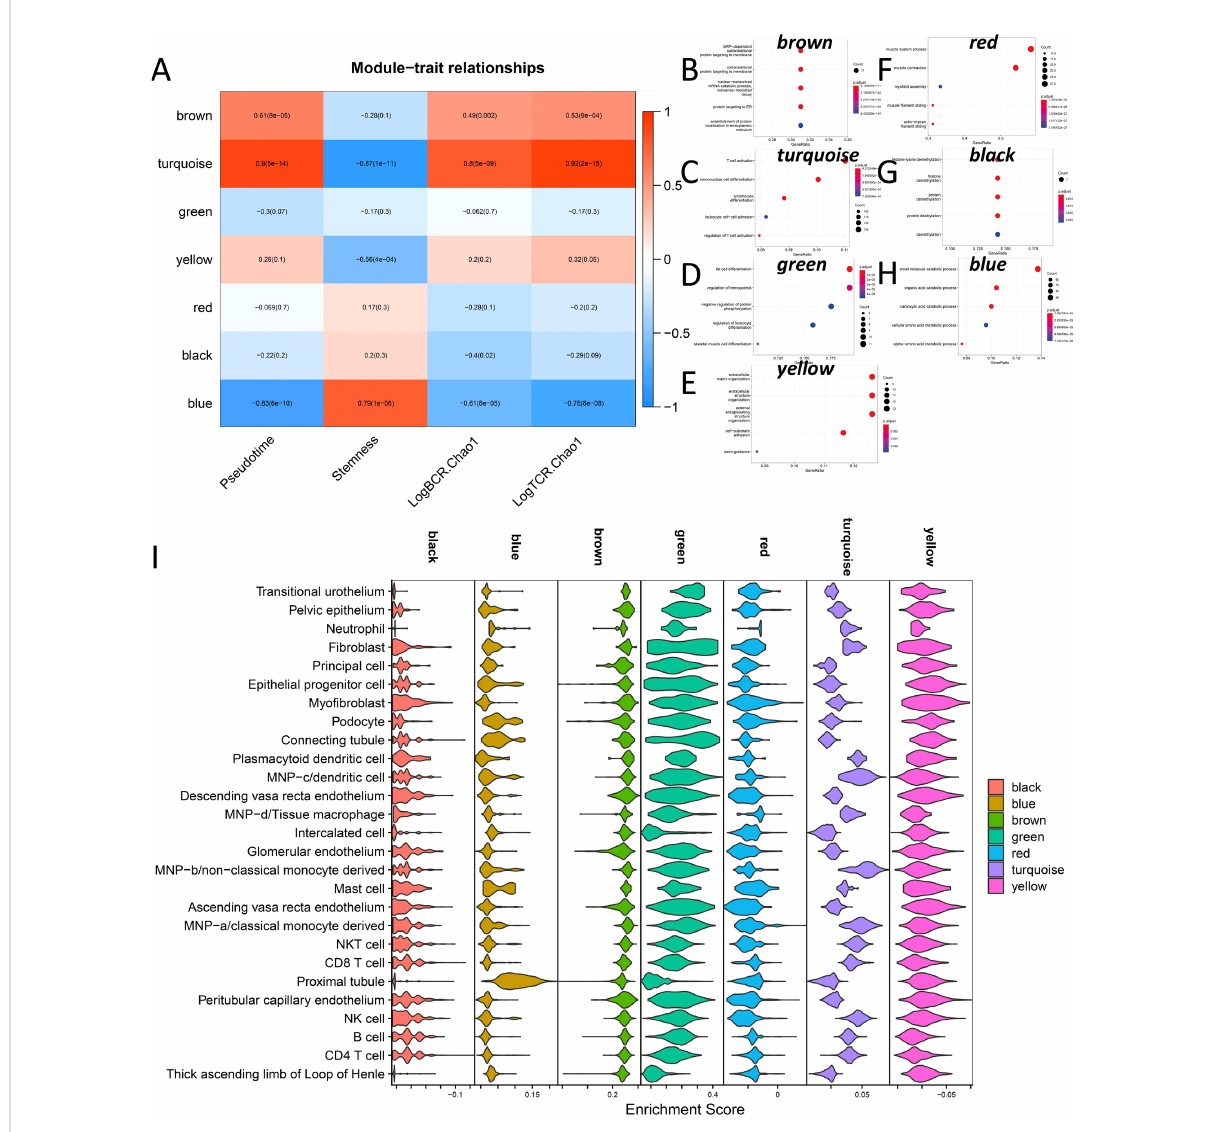
FIGURE 7 Co-expression network analysis during DN occurrence and development. (A) Correlation of 7 co-expression modules with Pseudotime, Stemness, LogBCR_Chao1, LogTCR_Chao1. (B – H) Functional enrichment analysis of seven co-expression module hub genes. (I) Enrichment of the hub genes in 7 co-expression modules at the single-cell